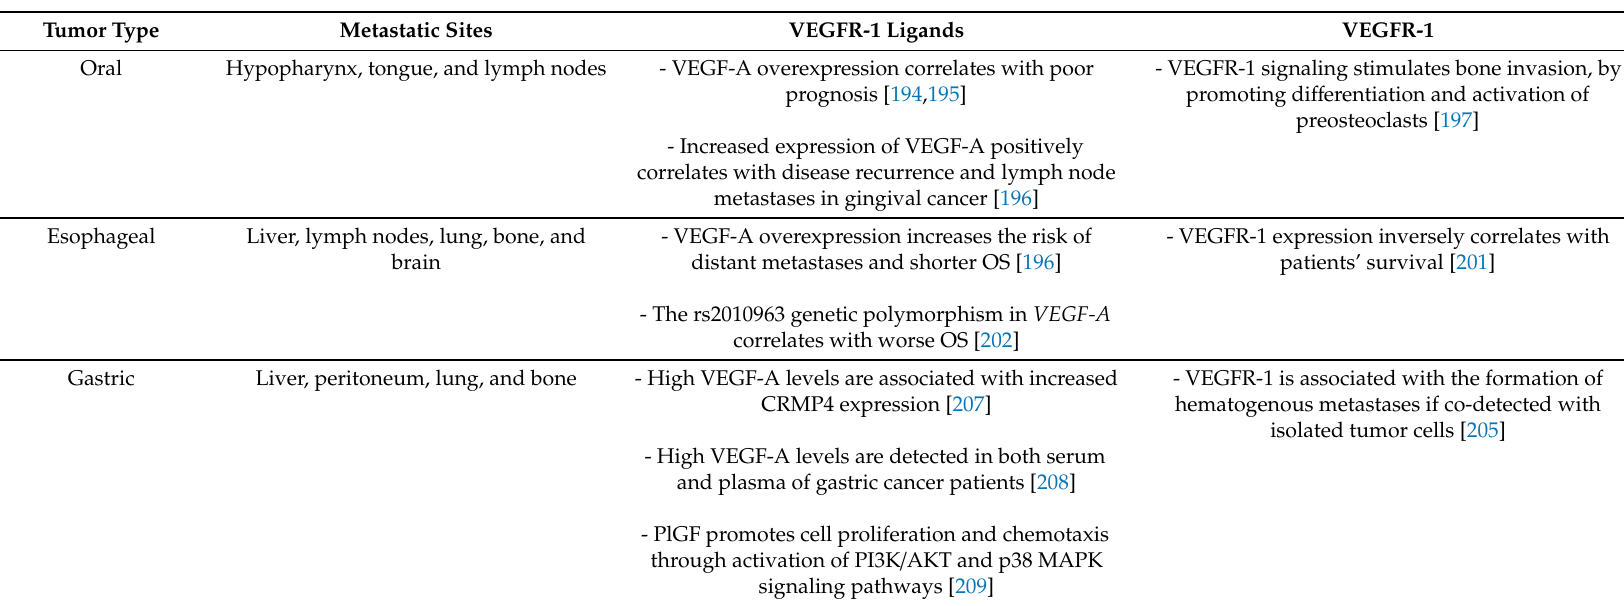
Table 2. Experimental evidence of the involvement of VEGFR-1 and its ligands in the metastatic spreading of cancers a ff ecting the gastrointestinal